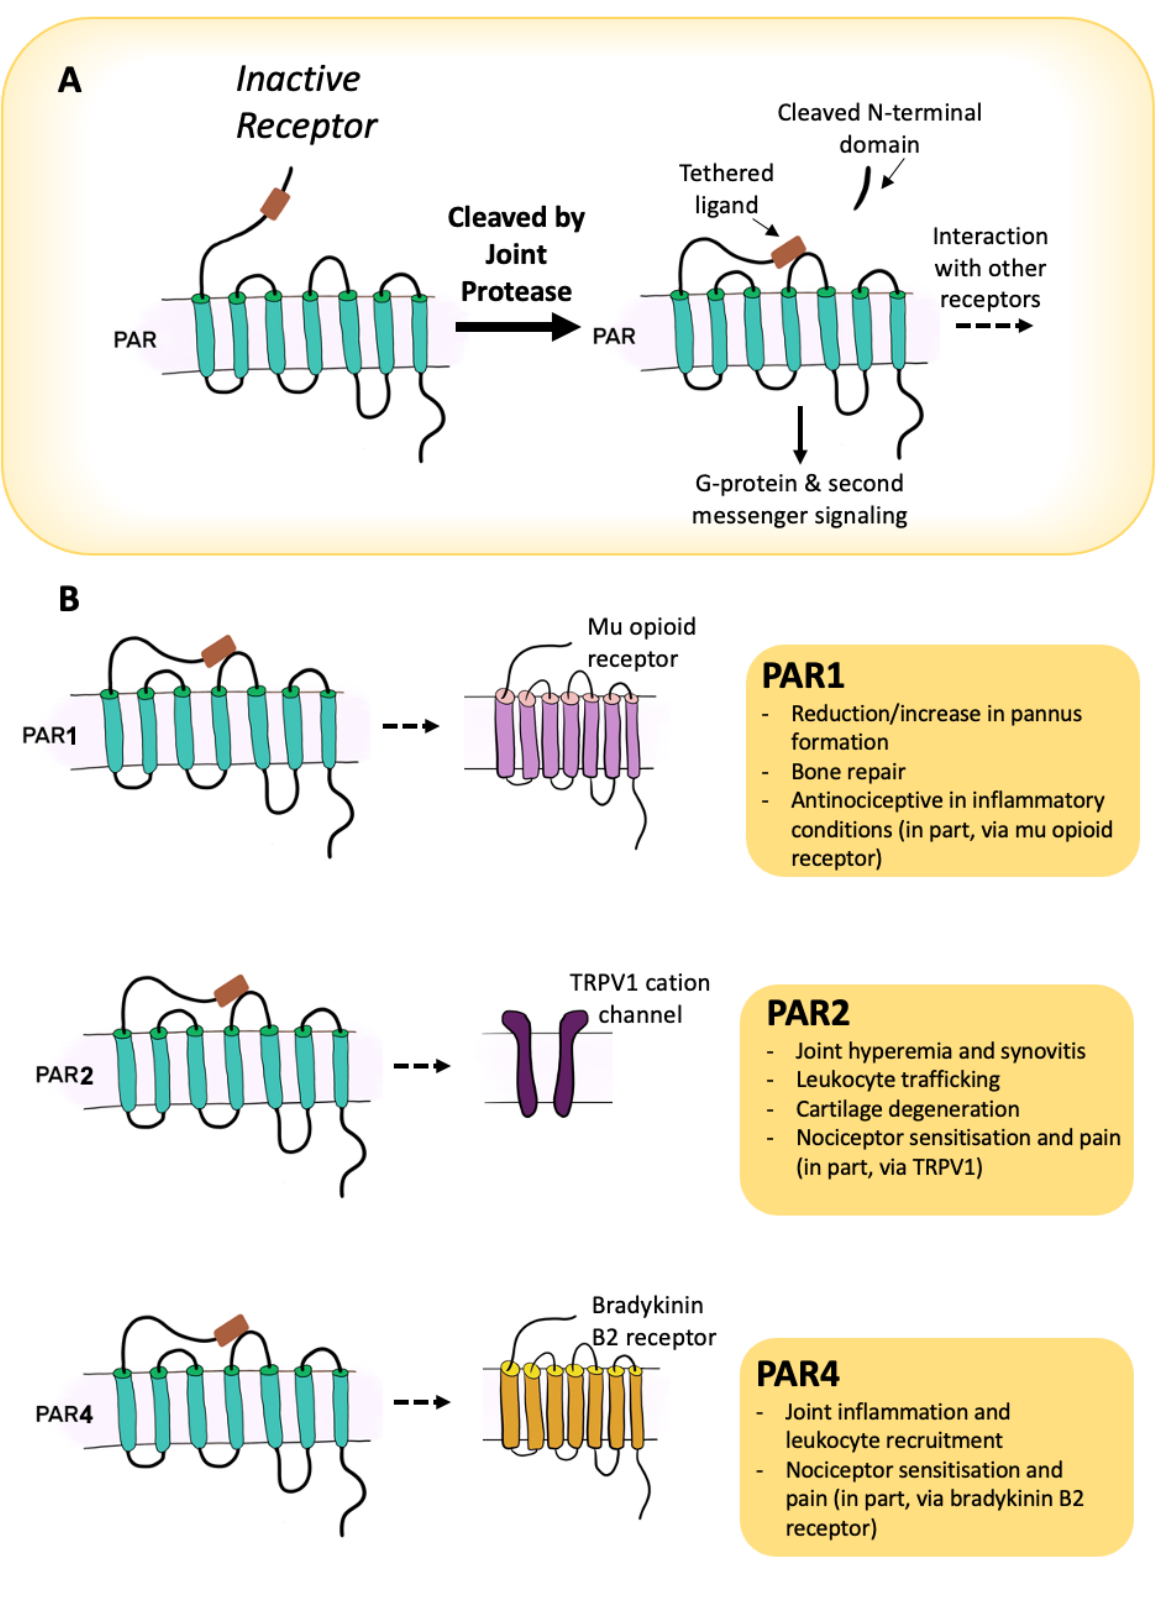
Figure 2. Overview of the role of PARs in the control of joint inflammation and pain. Activation of a PAR is achieved by cleavage of the receptor with a proteolytic enzyme to reveal a tethered ligand that binds to the second extracellular loop, leading to G protein coupling and signalling ( A ). In joints, PAR-2 and -4 tend to be pro-inflammatory and pro-nociceptive, whereas PAR-1 has some protective properties ( B ).